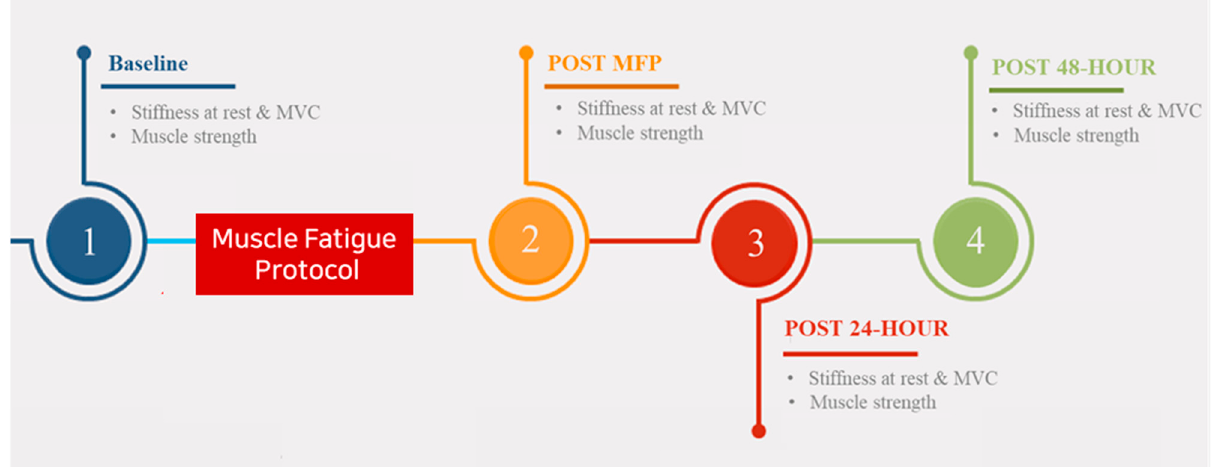
Figure 1. Experimental procedure. Abbreviations: MVC, maximum voluntary contraction; MFP, muscle fatigue protocol.